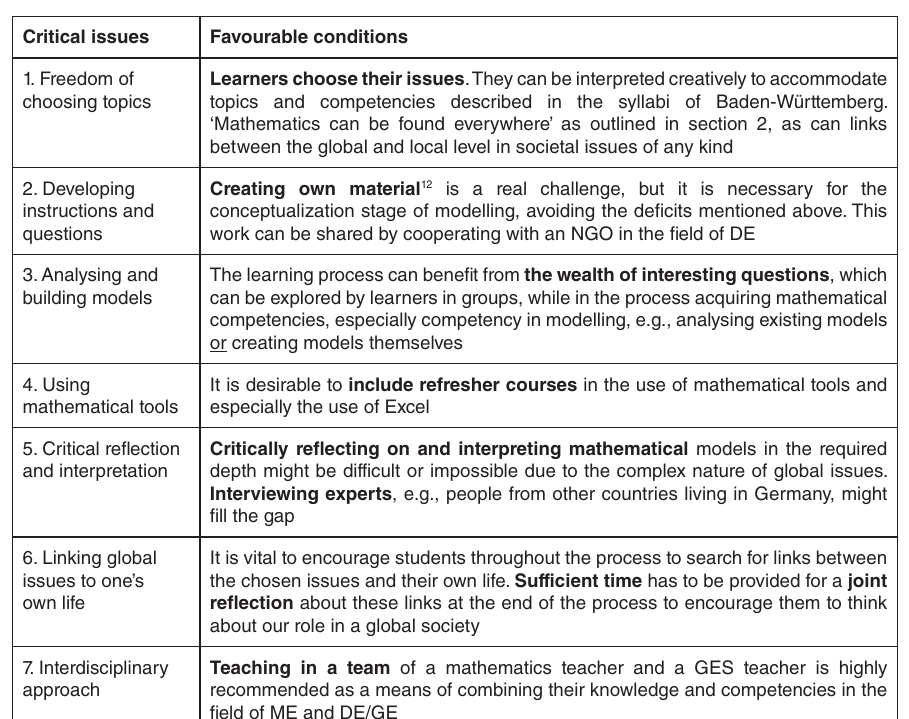
Table 3: Favourable learning conditions